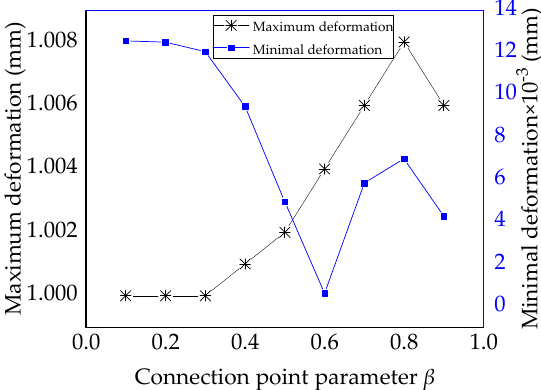
Figure 12. Maximum-minimum deformation of variable-angle laminates of [0 ± < 20 ( β ) 60 > ] 2s with connection point parameter β .